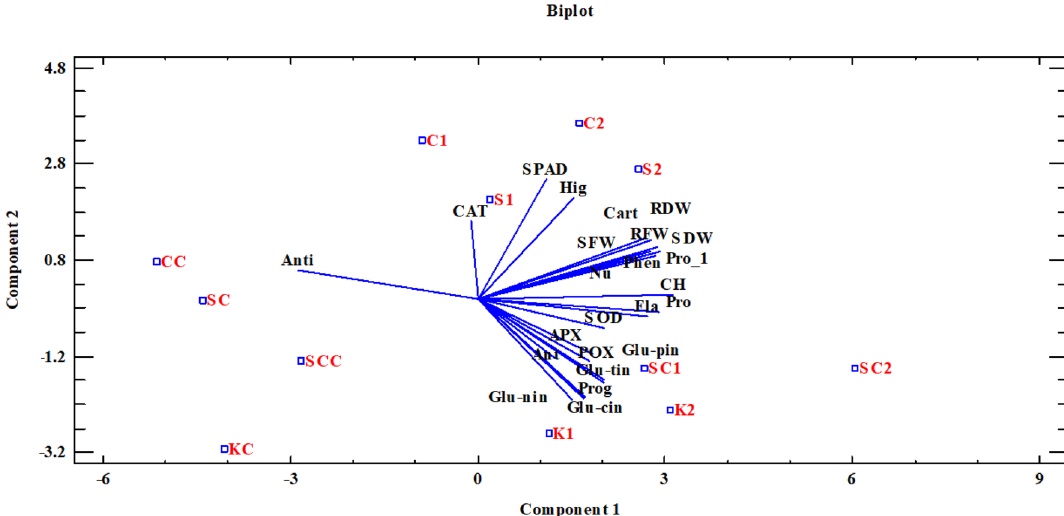
Figure 4. PCA analysis of all the evaluated parameters in cabbage cultivars. Collard & 0 mg/L amino acid (CC), Collard & 150 mg/L amino acid (C1), Collard & 300 mg/L amino acid (C2), Ka-red & 0 mg/L amino acid (KC), Ka-red & 150 mg/L amino acid (K1), Ka-red & 300 mg/L amino acid (K2), Ka-smooth & 0 mg/L amino acid (SC), Ka-smooth & 150 mg/L amino acid (S1), Ka-smooth & 300 mg/L amino acid (S2), Ka-scotch & 0 mg/L amino acid (SCC), Ka-scotch & 150 mg/L amino acid (SC1), Ka-scotch & 300 mg/L amino acid (SC2), Height (hig), Number of leaves per plant(Nu), Chlorophyll (SPAD), Shoot fresh weight (SFW), Shoot dry weight (SDW), Root fresh weight (RFW), Root dry weight (RDW), Total Chlorophyll (CH), Proline (Pro-1), Carotenoid (Cart), Anthocyanin (Ant), Phenol (Phen), Protein (Pro), Flavonoids (Fla), Antioxidant (Anti), Catalase (CAT), Peroxidase (POX), Ascorbate peroxidase (APX), Superoxide dismutase (SOD), Glucoraphanin (Glu-nin), Progoitrin (Prog), Gluconapin (Glu-pin), Glucobrassicin (Glu-cin), Gluconasturtiin